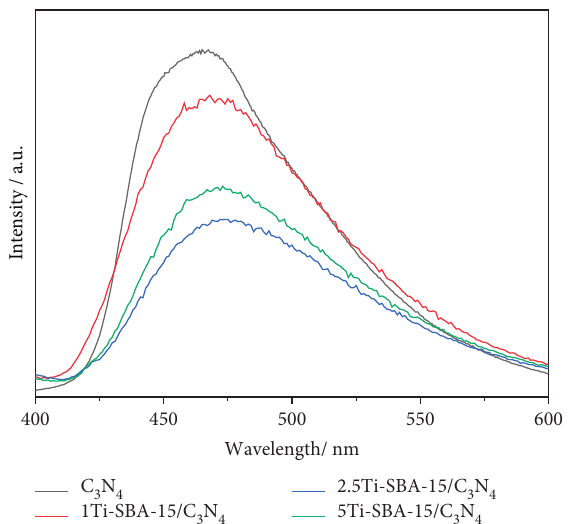
Figure 4: Photoluminescence spectra of pure C 15/C 3 N 4 . Figure 5: IR spectra of xTi-SBA-15/C